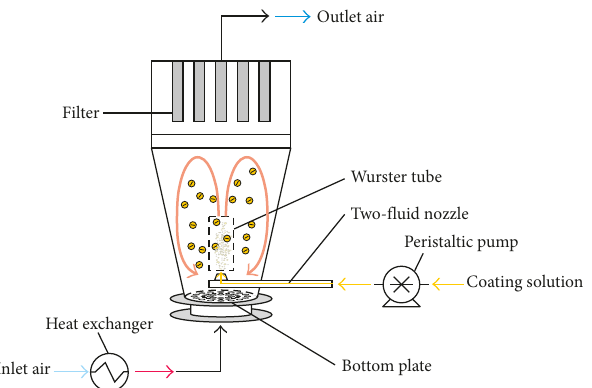
Figure 1: Schematic of the fluidized bed with a Wurster